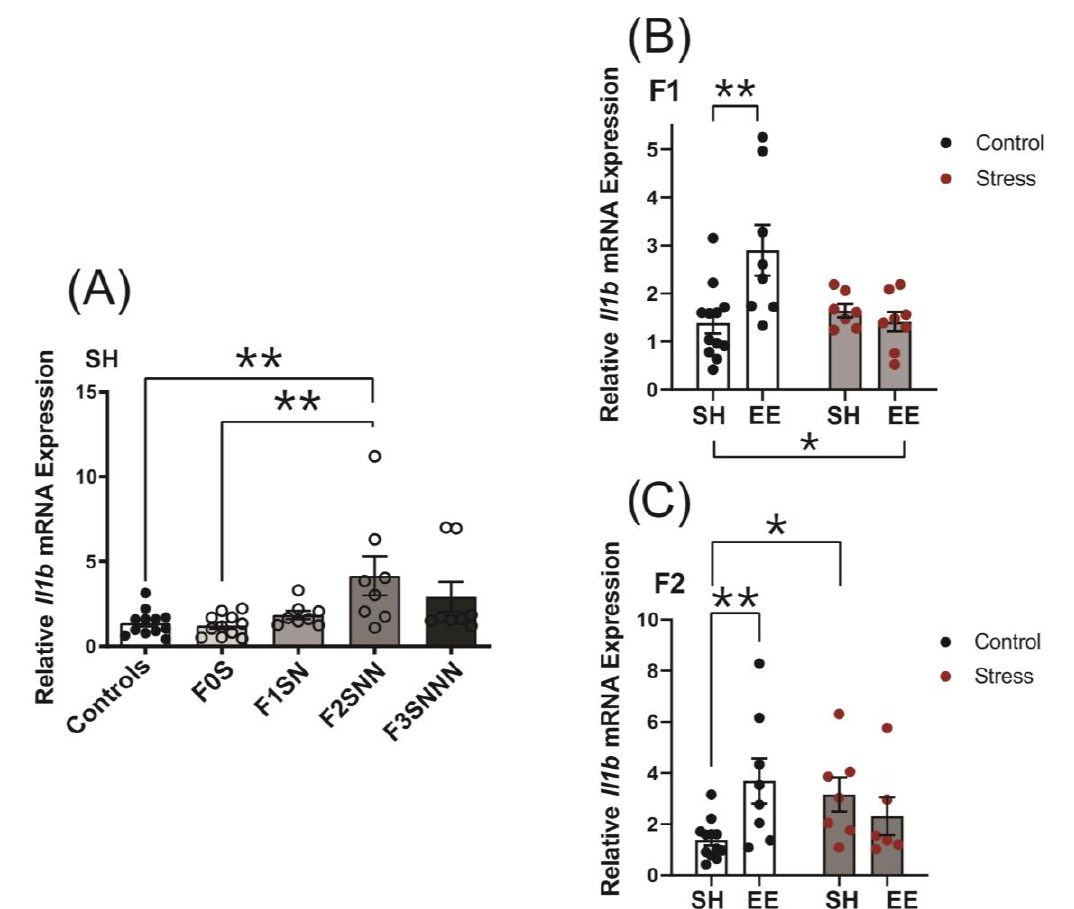
Figure 8. Uterine mRNA expression of Il1b increased significantly in the F2 generation exposed to transgenerational stress and in the F1 and F2 controls exposed to EE. ( A ) Il1b expression in F0–F3 dams subjected to CVS under SH. Uterine gene expression of Il1b in the ( B ) F1 and ( C ) F2 generations of controls and stressed animals exposed to SH or EE housing. Asterisks indicate significance: <0.05 (*); <0.002 (**). Data are compared to F0N, mean ± SEM. Ordinary one-way ANOVA ( A ) and two-way ANOVA ( B , C ) analyses were used. N = 8 – 12 ( A ); 7 – 12 (B); or 6 – 12 ( C ). SH = standard housing; EE = enriched housing; F = filial generation; S = stressed; N = nonstressed.